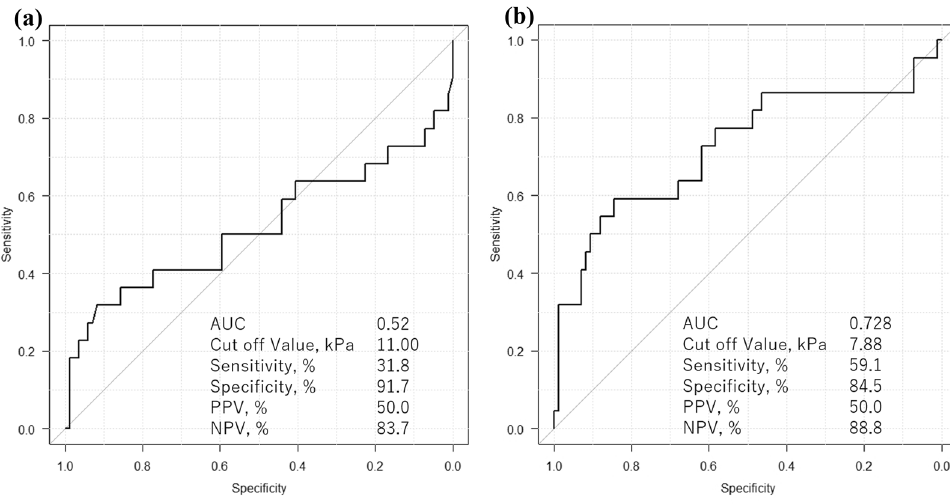
Figure 3. The receiver operating characteristic curve for the diagnostic ability of the mean ( a ) and range ( b ) values for pancreatic cancer. ( a ) With a cut-off value of 11.00 kPa, the sensitivity, specificity, positive predictive value (PPV), and negative predictive value (NPV) of SWE for the diagnosis of pancreatic cancer were 31.8%, 91.7%, 50.0%, and 83.7%, respectively. ( b ) With a cut-off value of 7.88 kPa, the sensitivity, specificity, PPV, and NPV of SWE for the diagnosis of pancreatic cancer were 59.1%, 84.5%, 50.0%, and 88.8%, respectively.